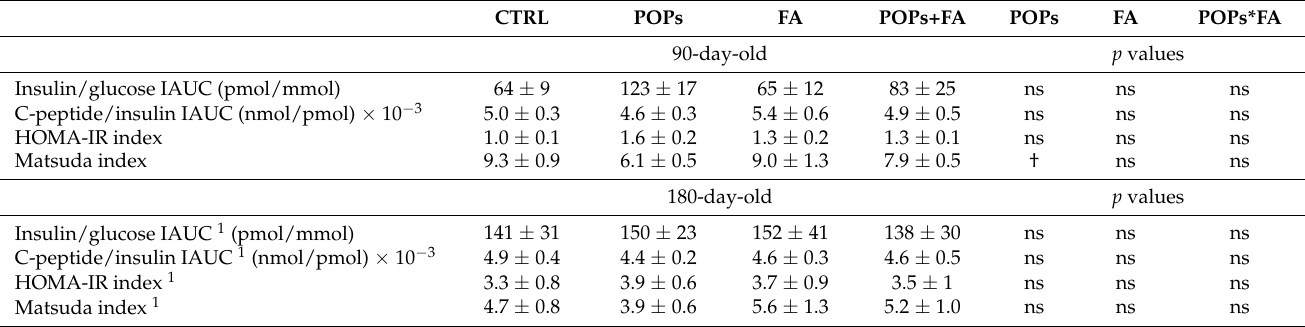
Table 5. Estimates of insulin sensitivity, insulin clearance (hepatic extraction) and β -cell function in F2 male rats. CTRL POPs FA POPs+FA POPs FA